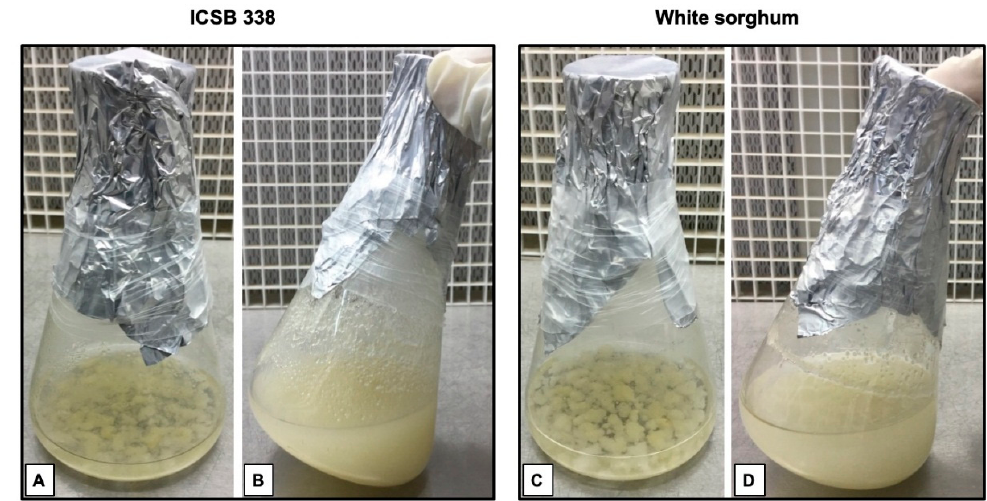
Figure 3. The establishment of ICSB 338 and White sorghum cell suspension cultures. ( A ) ICSB 338 callus masses on the day of cell culture initiation. ( B ) ICSB 338 culture suspension after two generations of sub ‐ culture. ( C ) While sorghum callus masses on the day of cell culture initiation. ( D ) White sorghum culture suspension after two generations of sub ‐ culture. Both ICSB 338 and White sorghum cell suspension cultures were initiated and maintained in liquid medium E (3 mg/L 2,4 ‐ D and 2.5 mg/L naphthaleneacetic (NAA)).